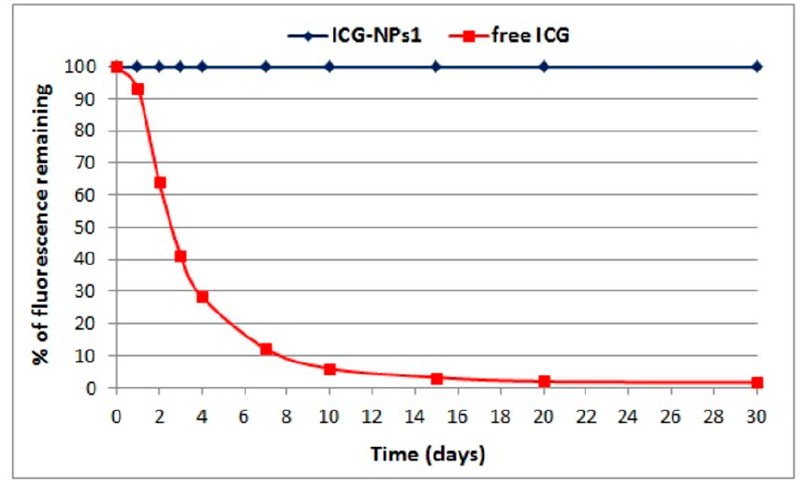
Figure 4. Fluorescence stability in water of free ICG solution and ICG-loaded NPs dispersion (ICG concentration, 10 µg/mL).